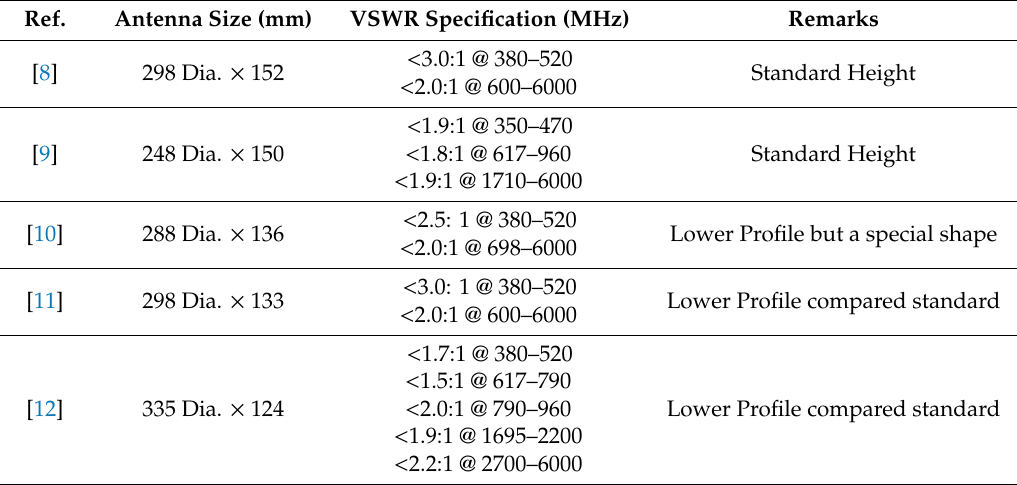
Table 1. Commercial antenna product standard sizes for PS / PPDR and the LTE cellular band.